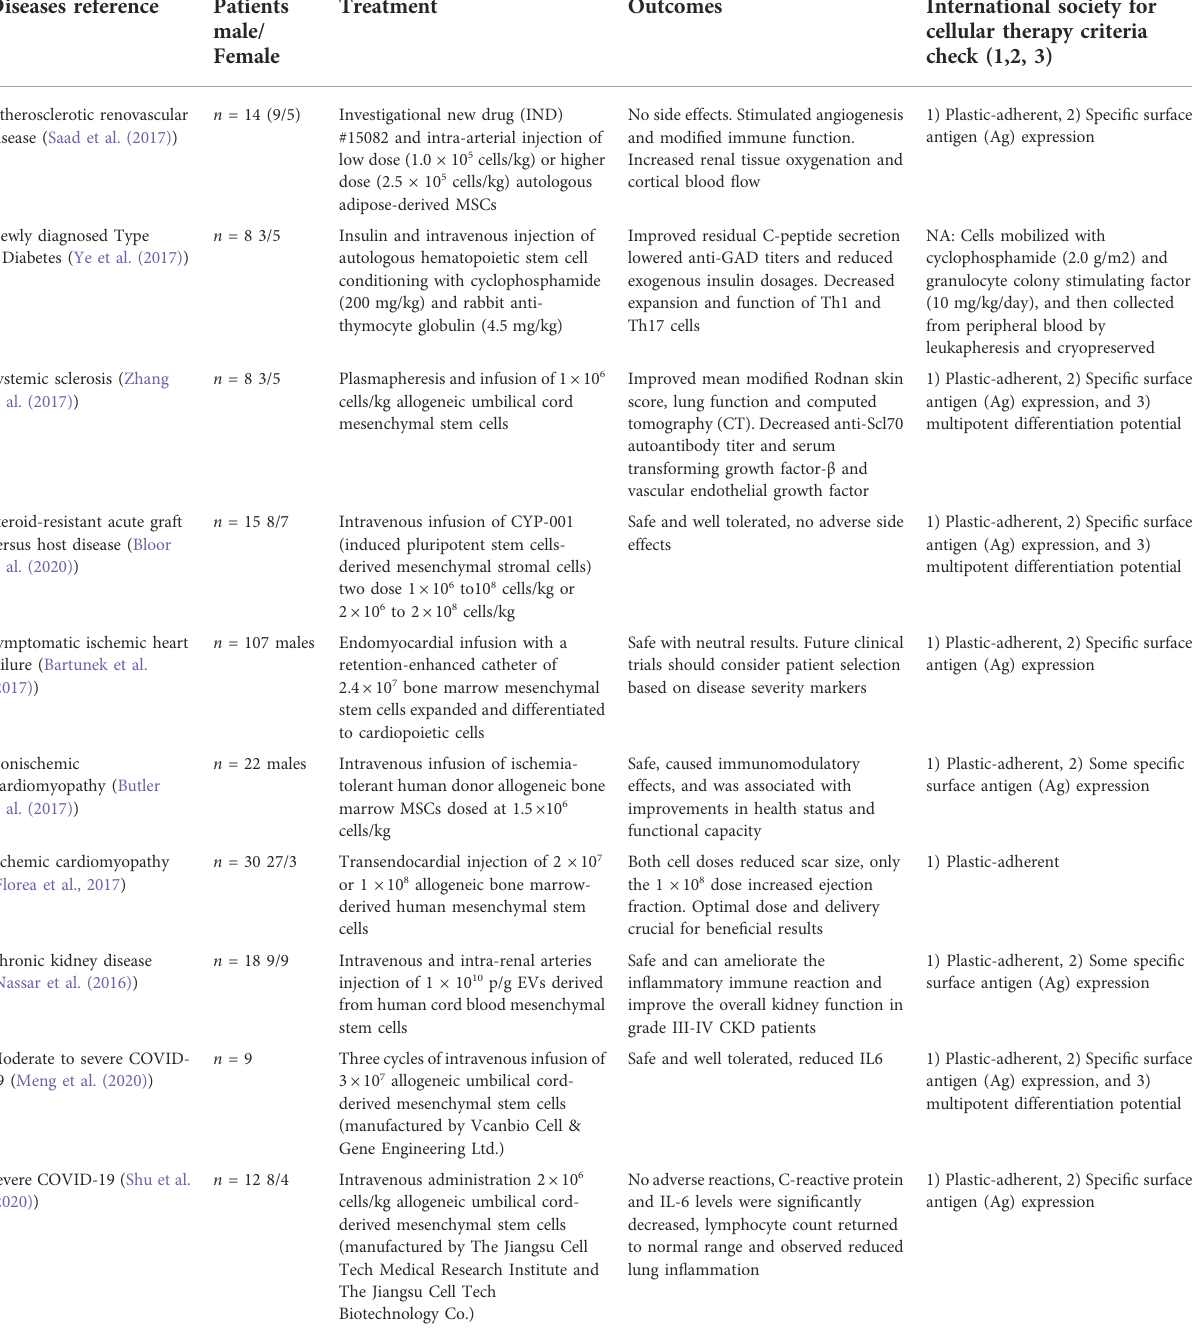
TABLE 2 A list of clinical trials using regenerative medicine applications. Each trial is identi fi ed by disease reference, patient gender, method of treatment, outcome, and International Society for Cellular Therapy Criteria Check (1, 2, 3). 1) MSC must be plastic-adherent when maintained in standard culture conditions. 2) MSC must express CD105, CD73 and CD90, and lack expression of CD45, CD34, CD14 or CD11b, CD79alpha or CD19 and HLA-DR surface molecules. 3) MSC must differentiate to osteoblasts, adipocytes and chondroblasts in vitro . Most clinical trials using MSC appeared to have the 1st and 2nd criteria mentioned, and a large difference was noted between the trials regarding cell number, type, from of transplantation,andcultureconditions. Suchvariationallows fortheidenti fi cationofdifferent formsofeffectperexperimentalgroupbutshows little consistency in the trials performed. Thus, it would be bene fi cial if clinical trials followed a clearer guideline with minor changes per experimental group to understand better the applicability and ef fi cacy of cellular and tissue engineered